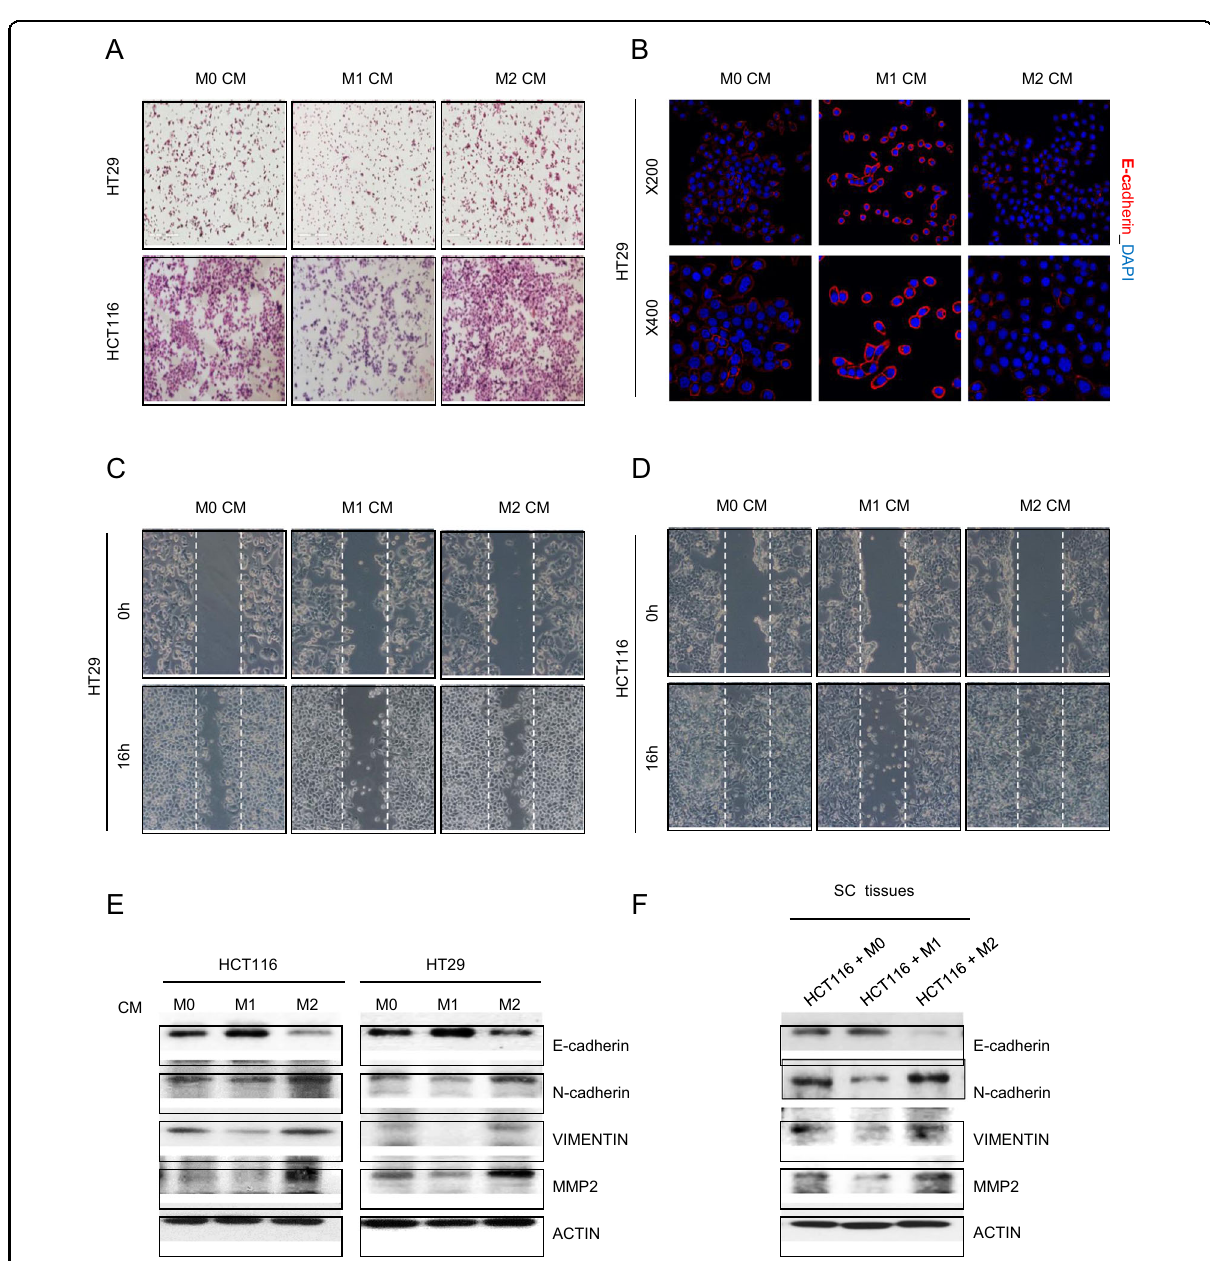
Fig. 3 Effects of macrophage CM on EMT in colon cancer cells. a Transwell Matrigel invasion assays of HT29 and HCT116 cells after coculture with macrophage CM for 24 h. b HT29 cells were subjected to immuno fl uorescence staining with an antibody against E-cadherin, were mounted with DAPI-containing mounting solution and observed at ×200 and ×400 magni fi cation. A wound-healing assay was performed by creating a wound on a con fl uent monolayer of HT29 c and HCT116 d cells during incubation with macrophage CM for 16 h. Expression levels of EMT markers in HCT116 and HT29 cells treated with macrophage CM for 24 h e and in mouse subcutaneous tissues f were evaluated by western blotting. Actin was used as a loading